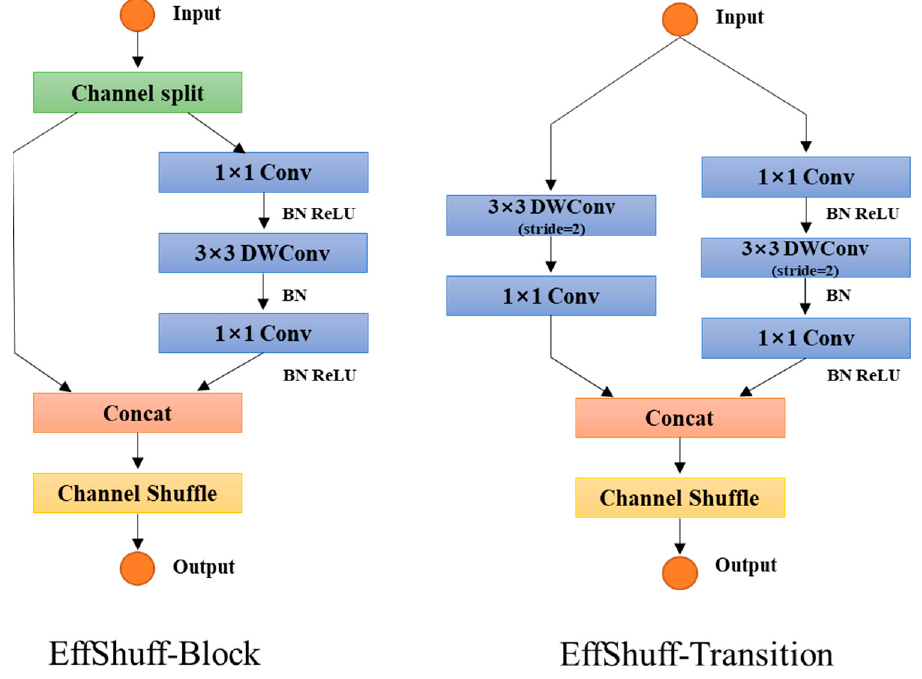
Figure 3. Architecture of EffShuffNet building blocks including EffShuff block and EffShuff transition.